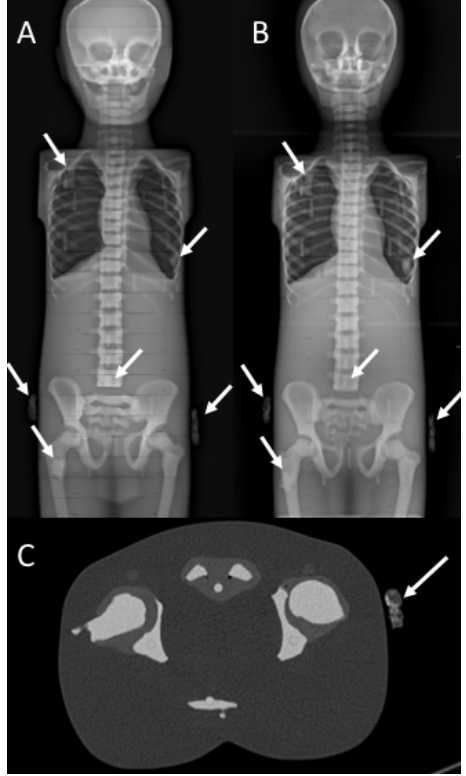
Figure 4. EOS ( A ), CR ( B ), and CT ( C ) images of a phantom with six inserts (arrows).